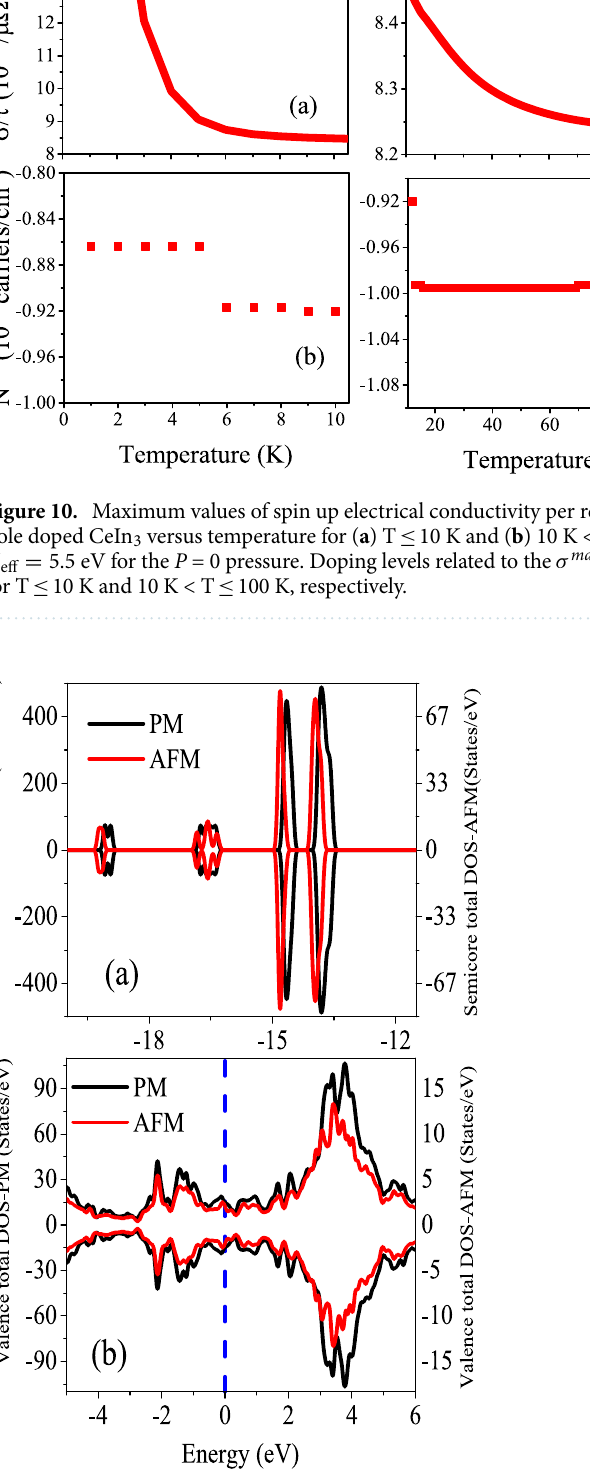
Figure 11. Total DOSs of CeIn 3 in ( a ) semicore and ( b ) valence regions at P = 0 calculated using GGA+U with U eff = 5.5 eV at paramagnetic (PM) and antiferromagnetic (AFM) phases. The vertical dash line in figure ( b ) indicates the Fermi